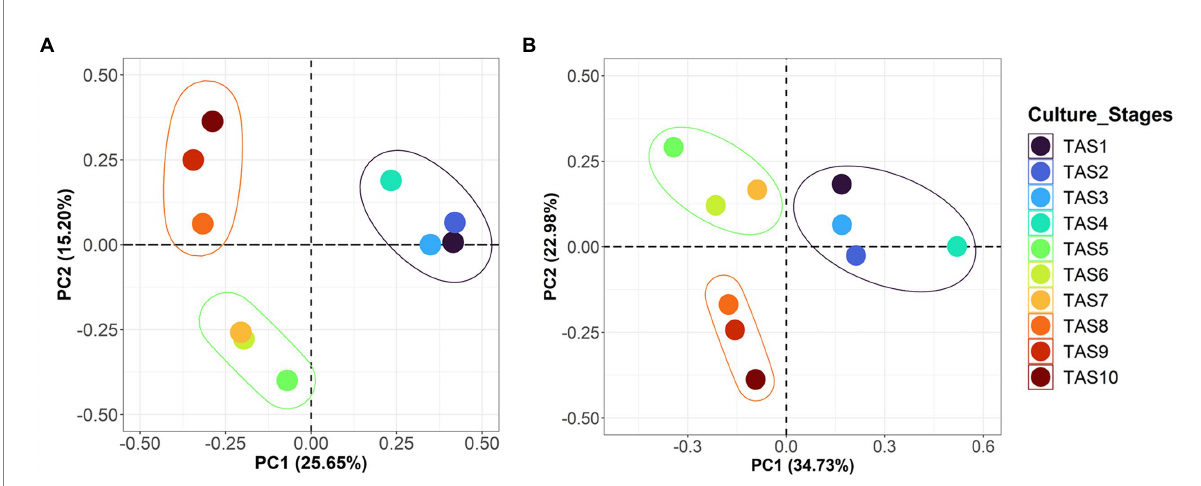
FIGURE 2 Compositional variations of bacterioplankton community in rearing water. Principal coordinate analysis (PCoA) plots represent beta diversity variations based on Bray-Curtis (A) weighted UniFrac (B) distance metrics in rearing water samples collected across various culture stages from a commercial BFT-based aquaculture system. The designated sample IDs (TAS1 to TAS10) represent shrimp Litopenaeus vannamei culture stages in terms of their growth days 6, 20, 34, 48, 69, 83, 104, 118, 132, and 146, respectively, in culture